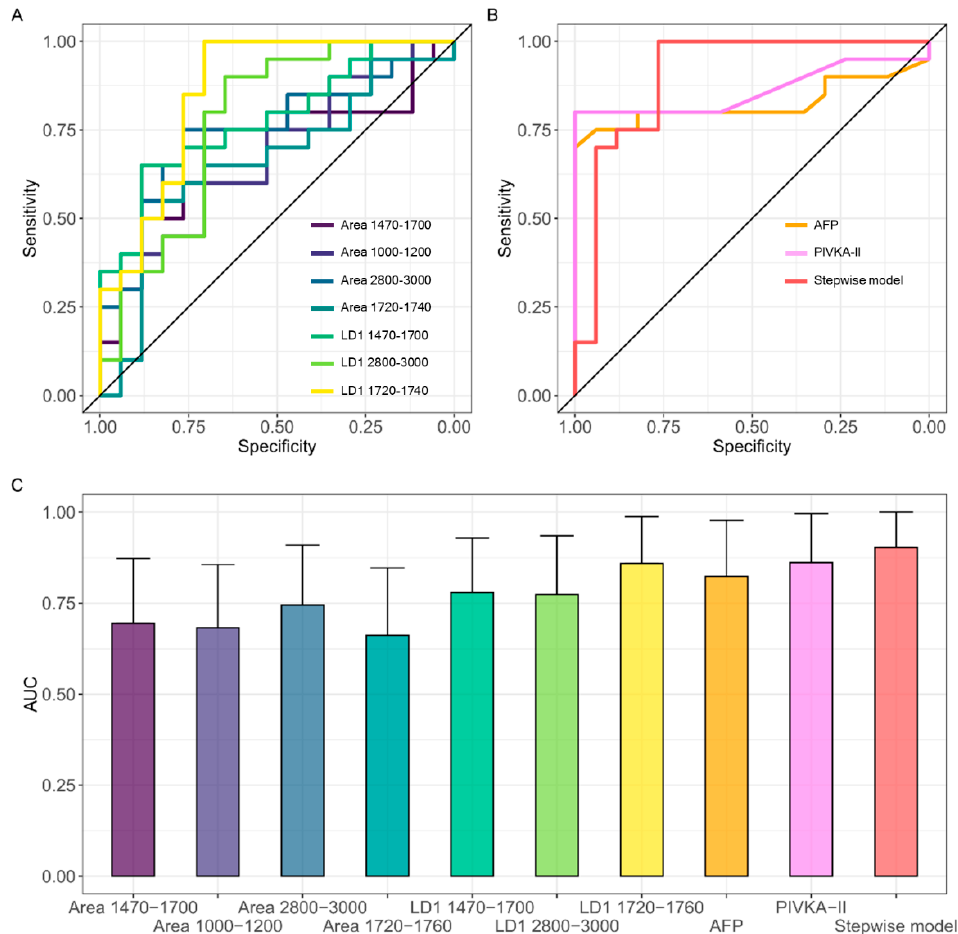
Figure 6. ROC analysis of the all the analyzed spectral biomarkers ( A ) and of AFP (gold), PIVKA-II (violet), and of the combined spectral biomarkers obtained with stepwise logistic regression (red) ( B ); AUC values for each of the investigated markers, alone and in combination, together with the corresponding 95% confidence interval ( C ). The same color scale is used in the three panels.